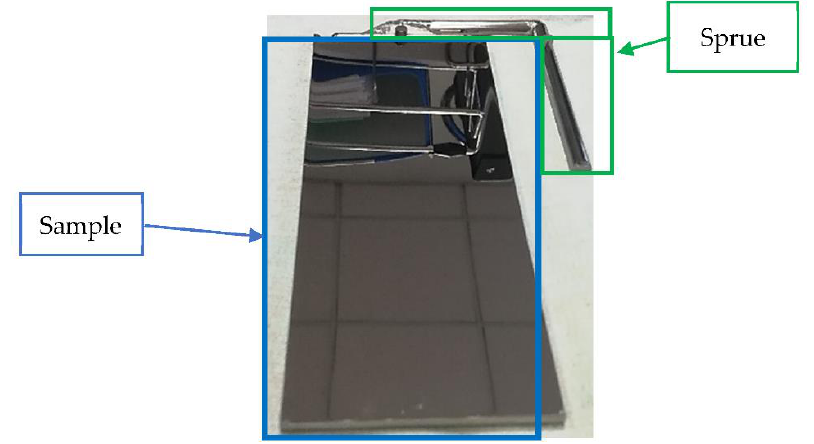
Figure 1. Industrial sample shape of the real part after the sputtering process.